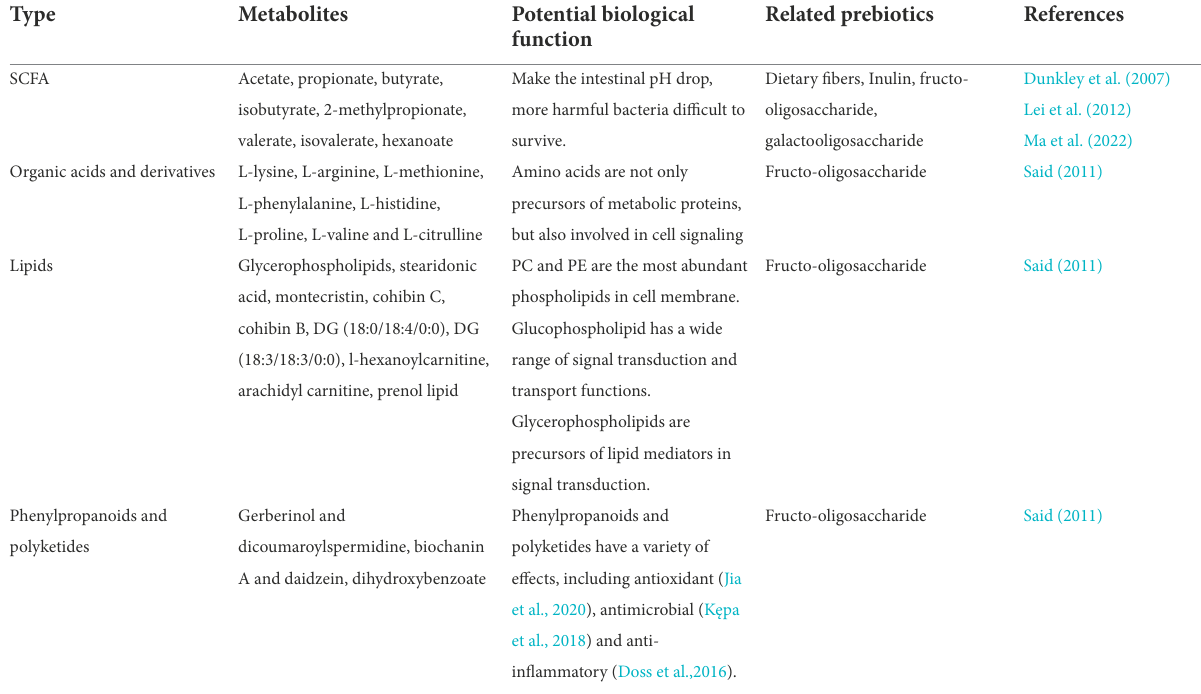
TABLE 5 Intestinal microbial metabolites with